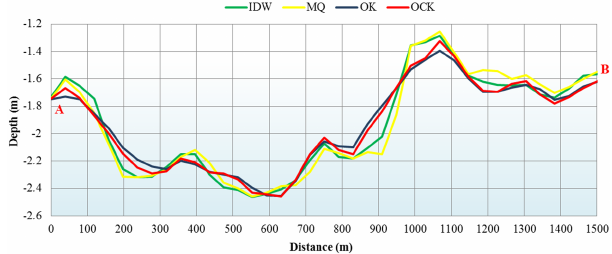
Figure 9. Differences in profile for the four best interpolation meth- ods.